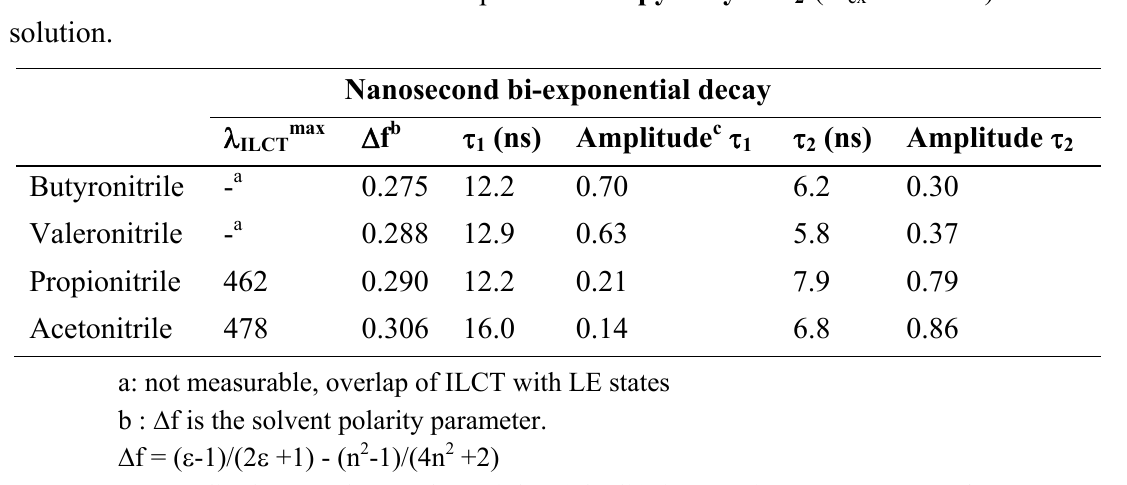
Table 3. Lifetimes and normalized amplitudes of TpyPhPyrene